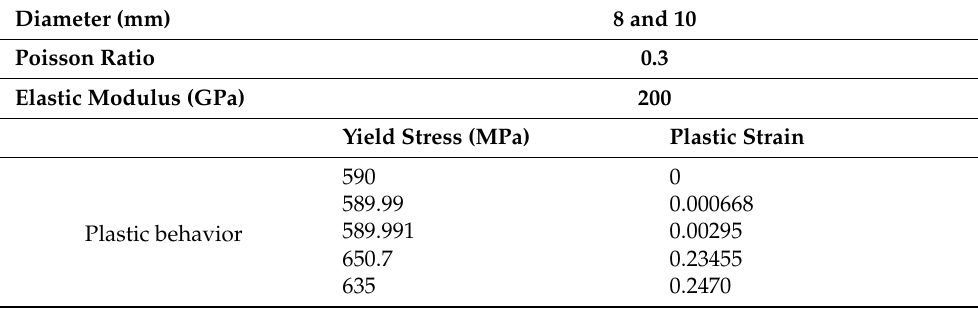
Table 10. Plastic properties of reinforcements in the flexural